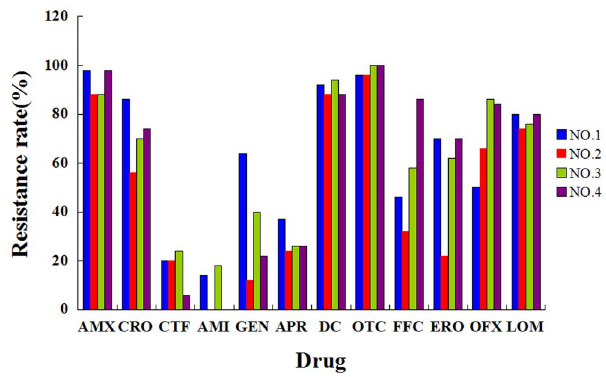
Figure 1. Resistance rates of Escherichiacoli isolates from four chicken farms to 12 antimicrobials. Abbreviations: AMX: amoxicil- lin, CRO: ceftriaxome, CTF: ceftiofur, AMI: amikacin, GEN: gentamicin, APR: apramycin, DC: doxycycline, OTC: oxytetracycline, FFC: florfenicol, ERO: enrofloxacin, OFX: ofloxacin, LOM: